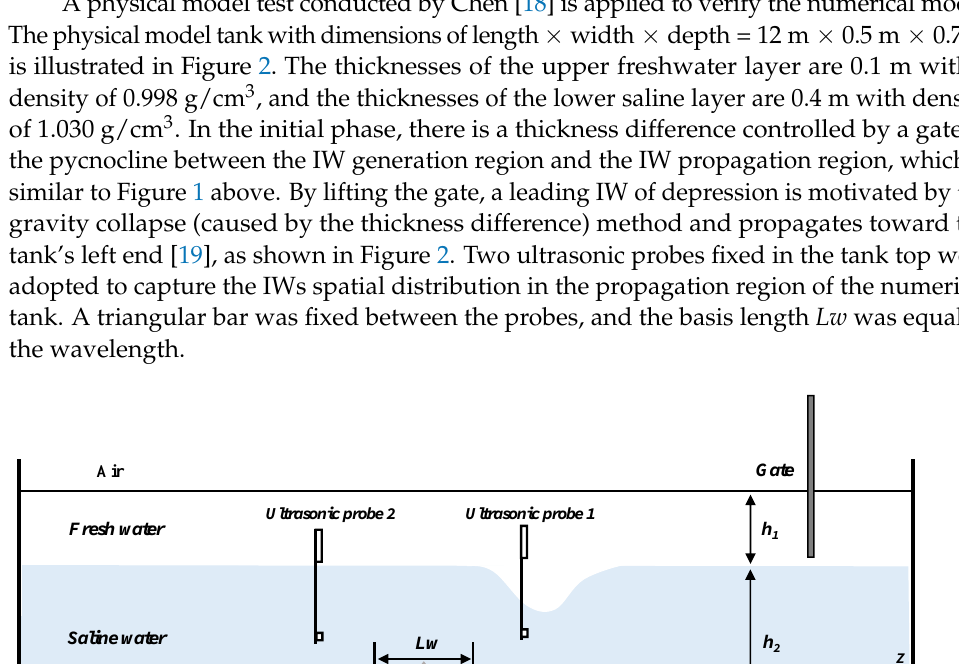
Figure 2. Schematic diagram of the physical model test [18].